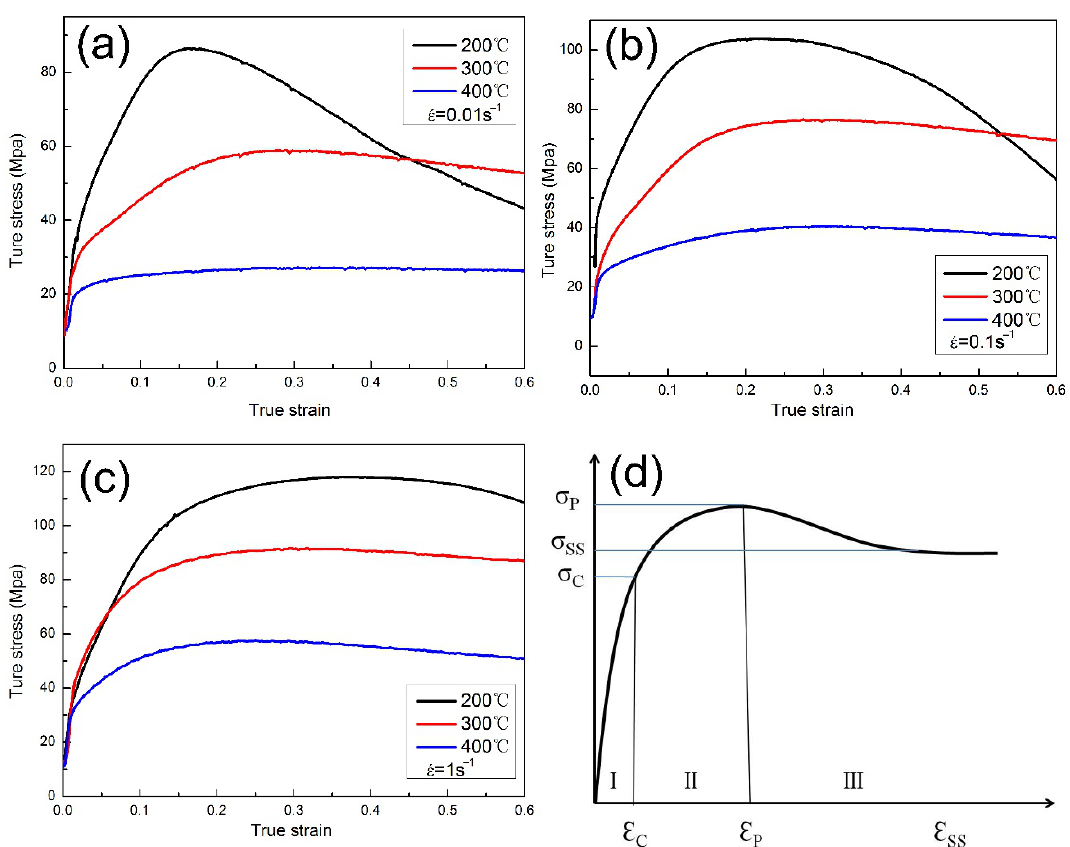
Figure 2. True stress–true strain curves of LA11 alloy under different deformation conditions: ( a ) ´ ε = 0.01 s − 1 , ( b ) ´ ε = 0. 1 s − 1 , ( c ) ´ ε = 1 s − 1 ; ( d ) a schematic sketch of isothermal compression behavior.